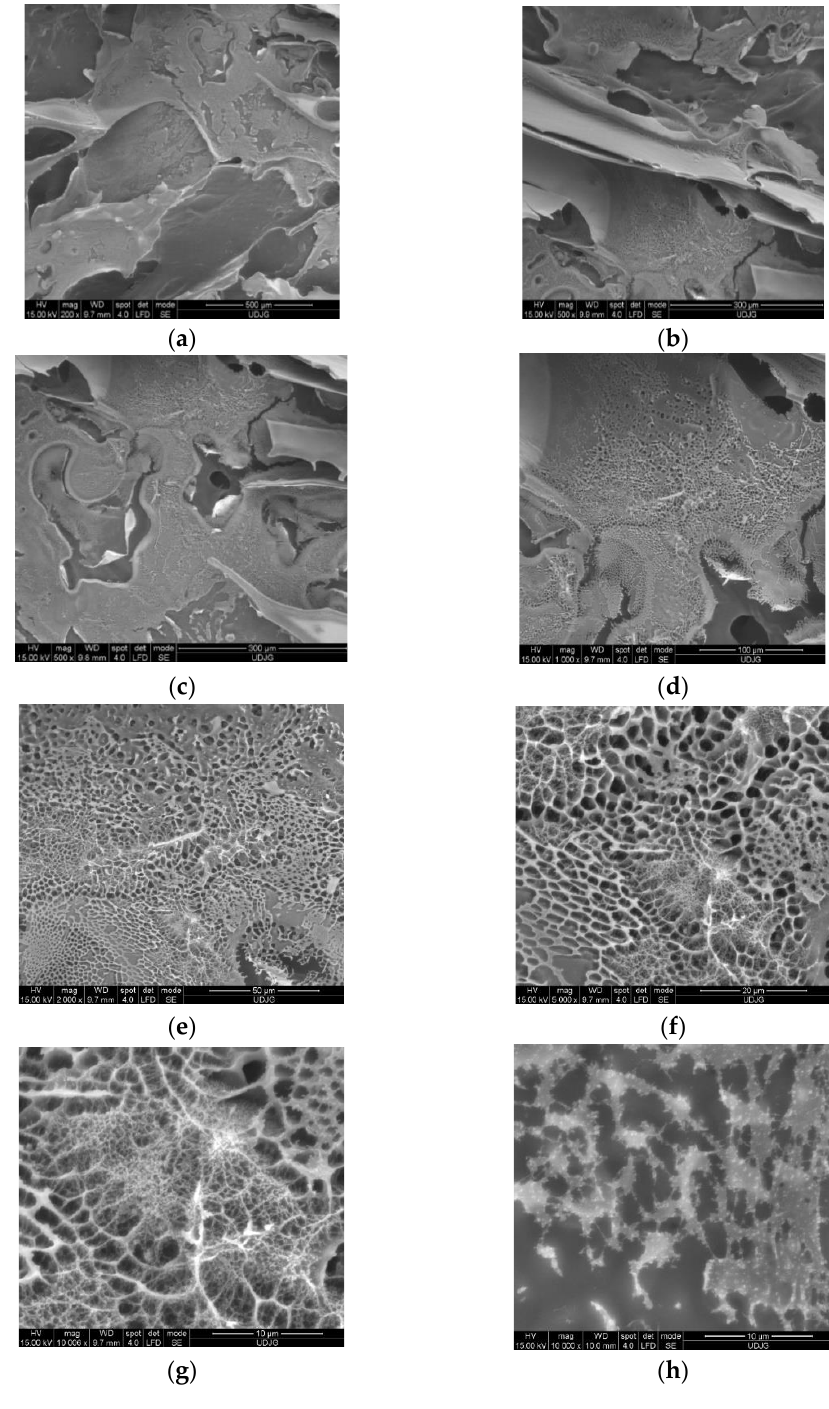
Figure 4. SEM micrographs of the V2 powder at magnification of 200× ( a ), 500× ( b , c ), 1000× ( d ), 2000× ( e ), 5000× ( f ) and 10000× ( g , h ).